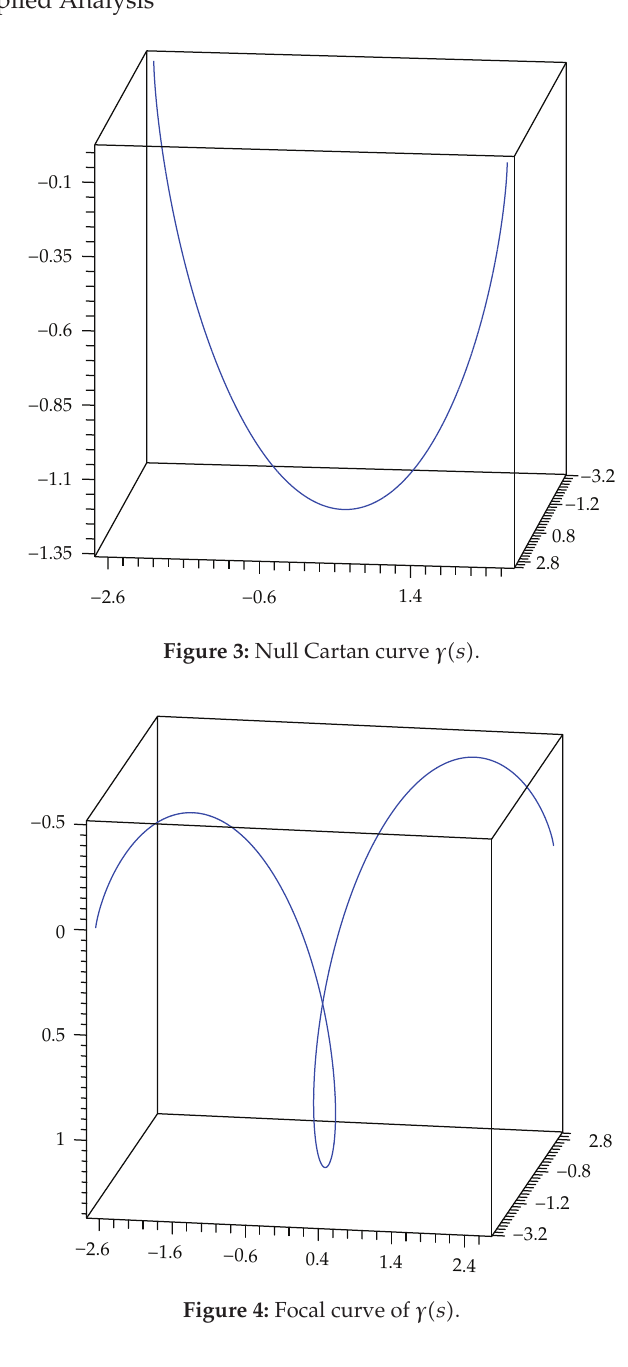
Figure 4: Focal curve of γ (cid:3) s (cid:4)